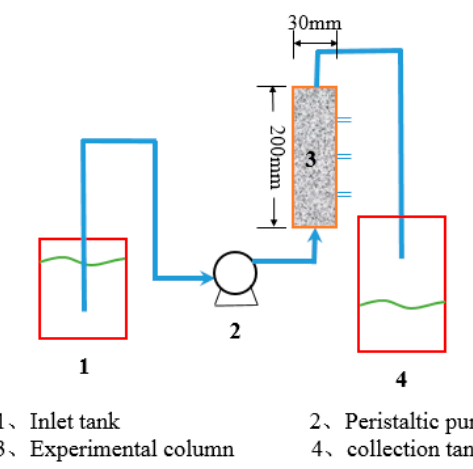
Figure 1. The schematic diagram of the experimental setup.